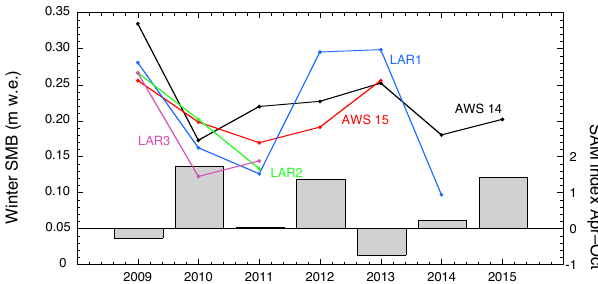
Figure 5. Time series of winter (April–October) SMB (mw.e.) de- rived from sonic height rangers, with left vertical axis. Magnitude of the southern annular mode (SAM) is shown as grey bars, with the right vertical